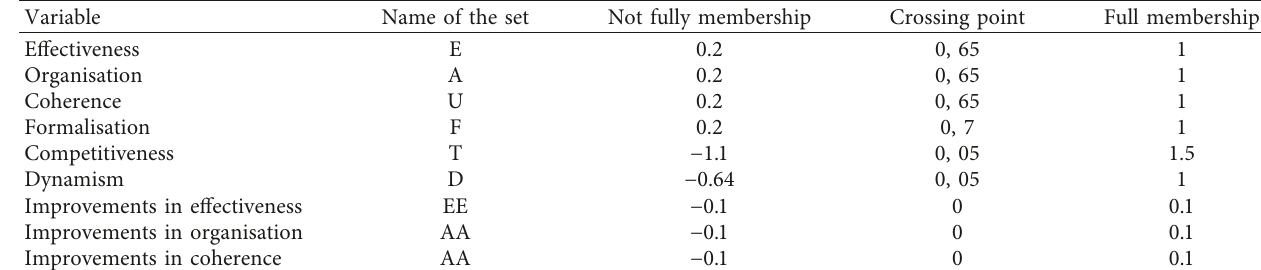
Table 4: Calibration of the variables and identification of the sets.